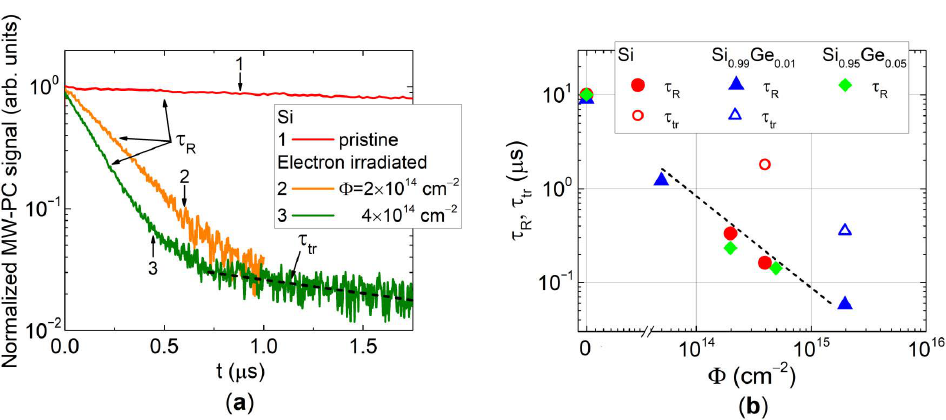
Figure 4. ( a ) Carrier decay transients recorded by MW-PC technique in Si diodes irradiated with 5.5 MeV electrons collecting di ff erent fluence. ( b ) Carrier lifetimes ascribed to their decay